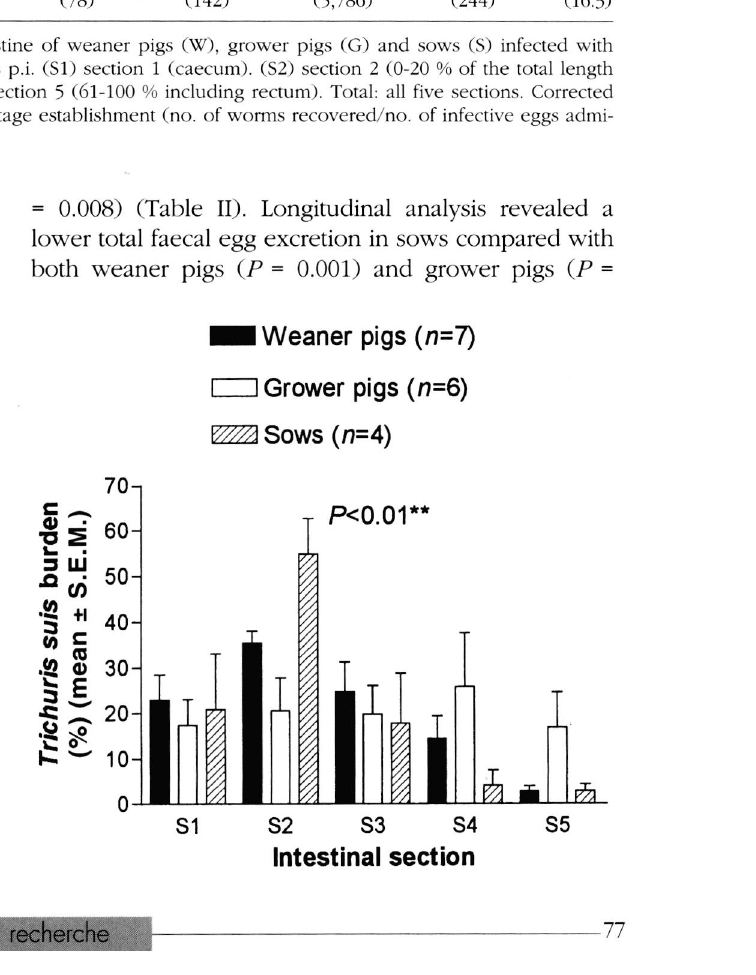
Fig. 1. - Comparison of the relative distribution (%) (mean ± S.E.M.) of Trichuris suis in sows, weaner and grower pigs. (SI) caecum. (S2) 0-20 % of the total length of colon. (S3) 21-40 %. (S4) 41-60 %. (S5) 61-100 % including rectum. A higher percentage of the worm burden was found in section two of sows compared with younger pigs (P =